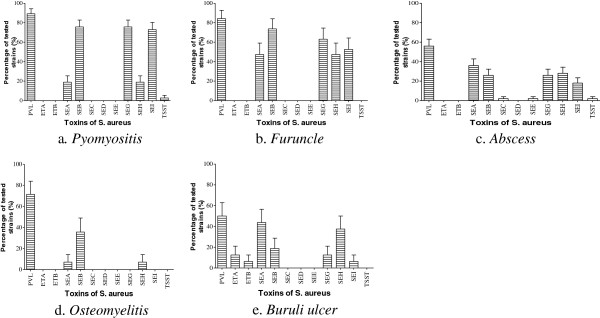
Specificity of the toxins production by the S. aureus strains isolated from primary and secondary infections. PVL: Panton-Valentine Leukocidin; ETA: Exfoliative Toxin A; ETB: Exfoliative Toxin B; SEA: staphylococcal enterotoxin A; SEB: staphylococcal enterotoxin B; SEC: staphylococcal enterotoxin C; SED: staphylococcal enterotoxin D; SEE: staphylococcal enterotoxin E; SEG: staphylococcal enterotoxin G; SEH: staphylococcal enterotoxin H; SEI: staphylococcal enterotoxin I; TSST: Toxic-shock syndrome Toxin. Means ± standard deviations (SD) for three experiments are given.